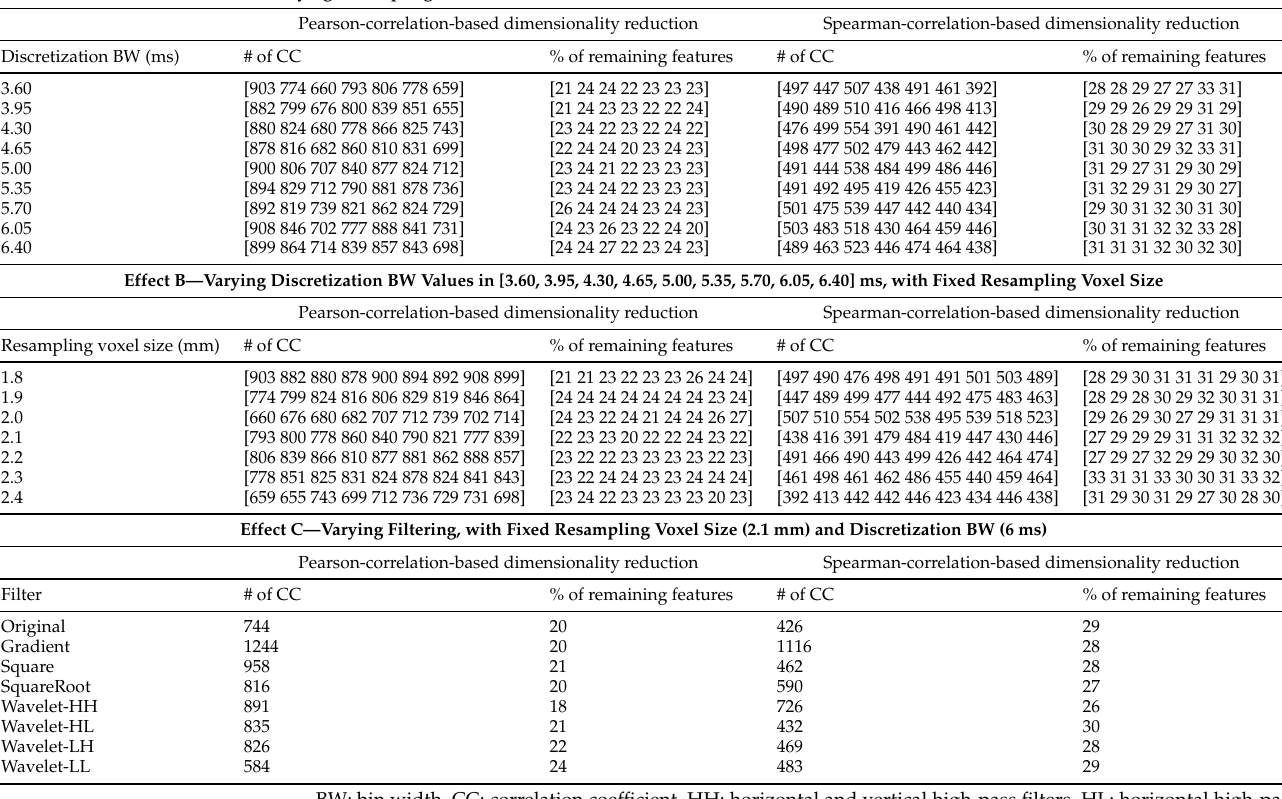
Table 2. Collinearity analysis and correlation-based dimensionality reduction for T1 maps. In the column “# of CC”, the number of pair-wise correlation coefficients that were significant and, in absolute value, greater than the predefined threshold is reported (see Section 2.5 for details). In the column “% of remaining features”, the percentage of remaining features after the correlation-based dimensionality reduction is